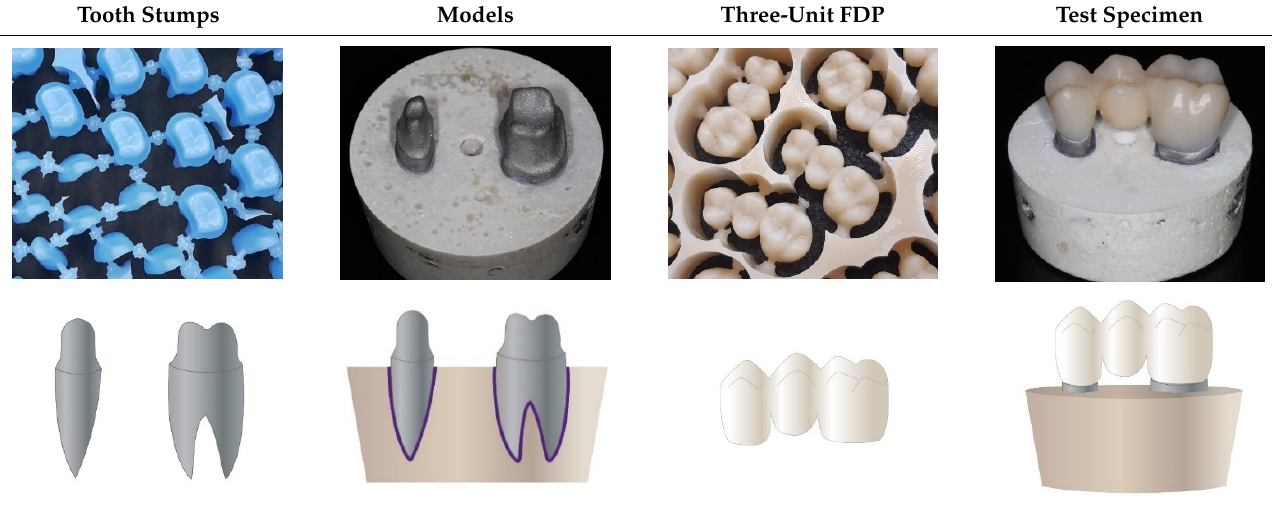
Table 3. Illustration of the fabrication process of tooth stumps, models, FDPs, and test specimens. Tooth Stumps